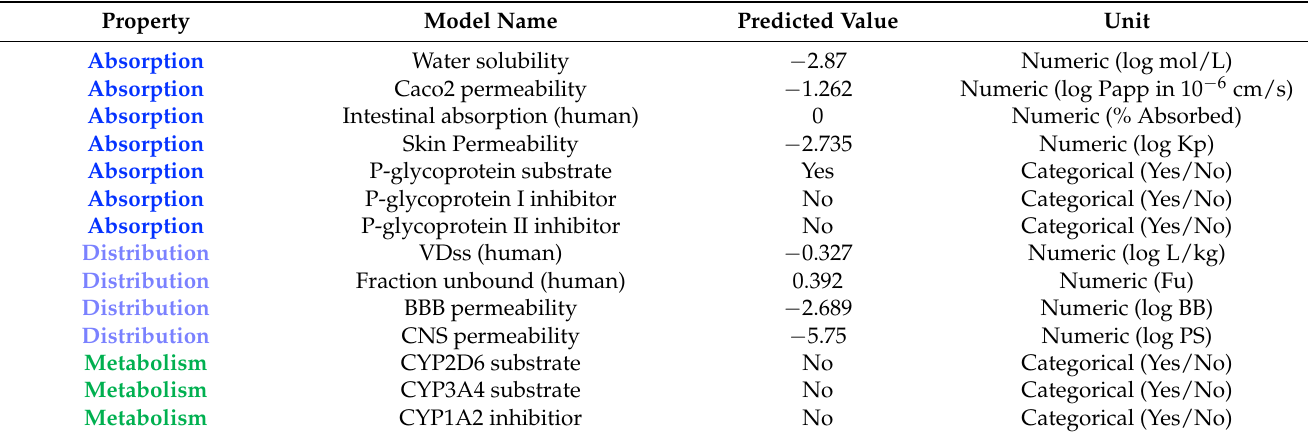
Table 4. ADMET data of bromelain predicted by PKCSM